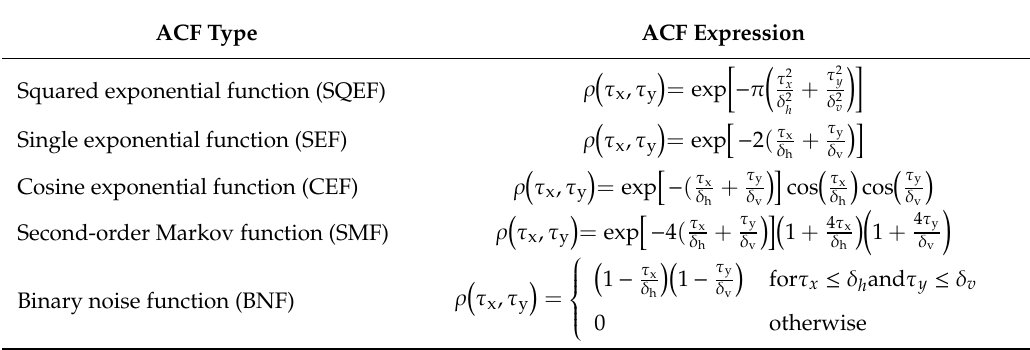
Table 1. Commonly used two-dimensional classical autocorrelation functions (ACFs) (adapted from [8]). ACF